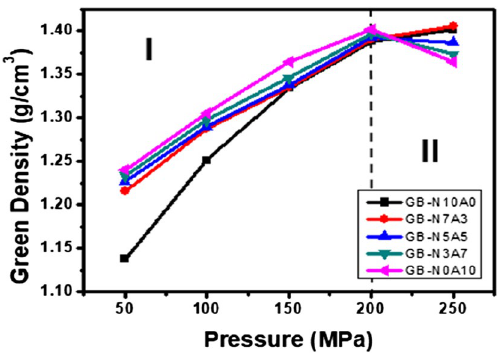
Figure 2. Green density changes due to molding pressure at a constant air flow rate.